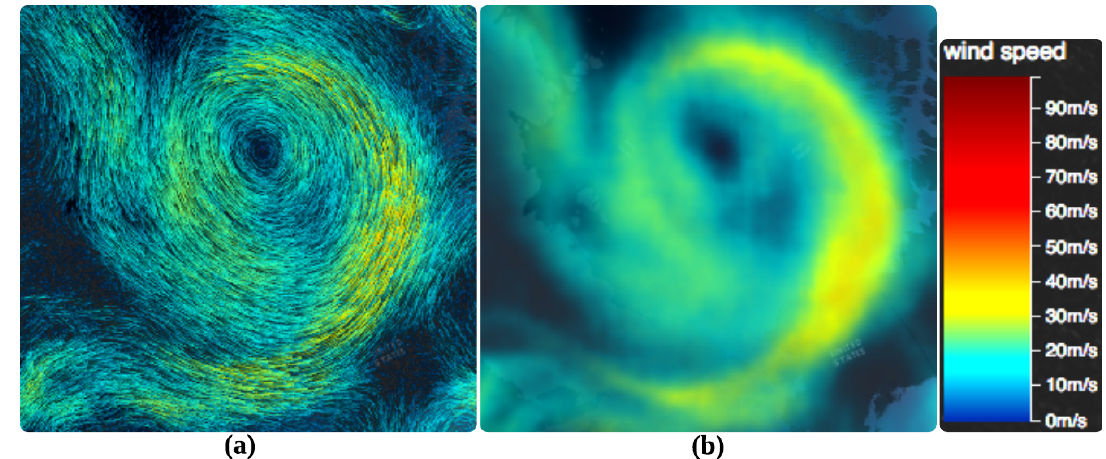
Figure 2. Screenshot of cyclone visualization with different visualization techniques: ( a ) streamline; ( b ) volume